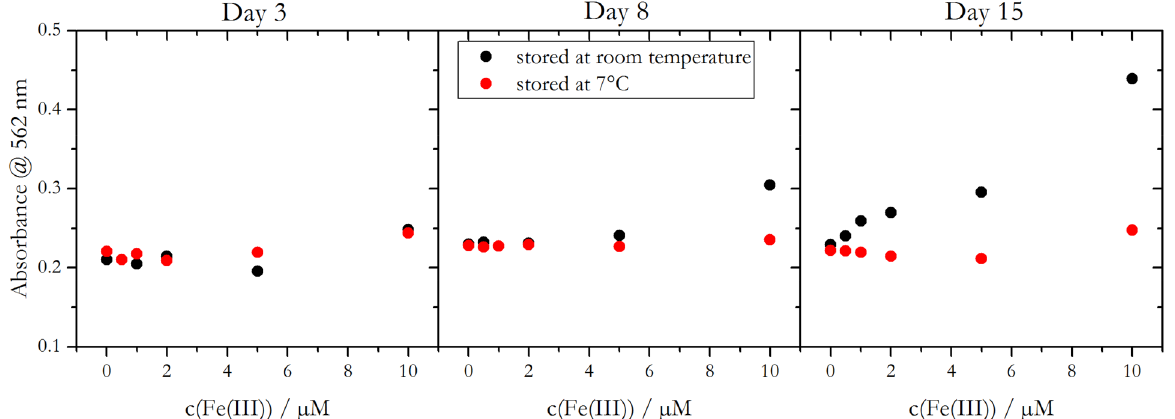
Figure 4. Absorbance at 562 nm of a 500 nM Mn(II) standard solution spiked with different amounts of Fe(III). Values were obtained after mixing standard solutions with two differently stored PAN/DFO-B reagents (at room temperature—black, at 7 °C—red) 3, 8 and 15 days after preparation. The two mixed PAN reagents contained 0.8 mM PAN and 400 µM